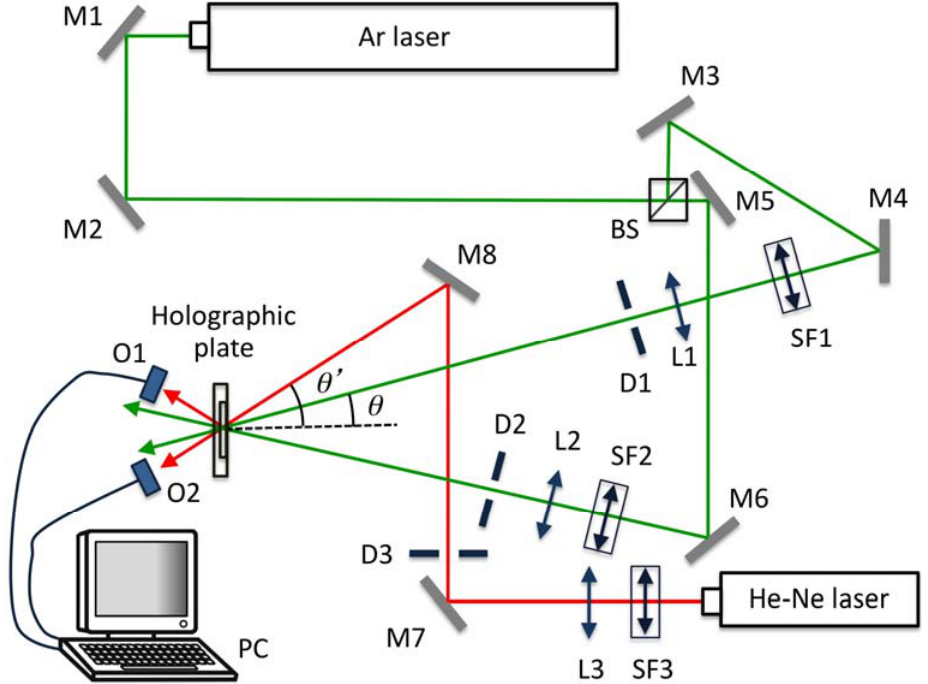
Figure 1. Experimental set-up. BS: Beamsplitter, Mi: mirror, SFi: spatial filter, Li: lens, Di: diaphragm, Oi: optical power meter, PC: data